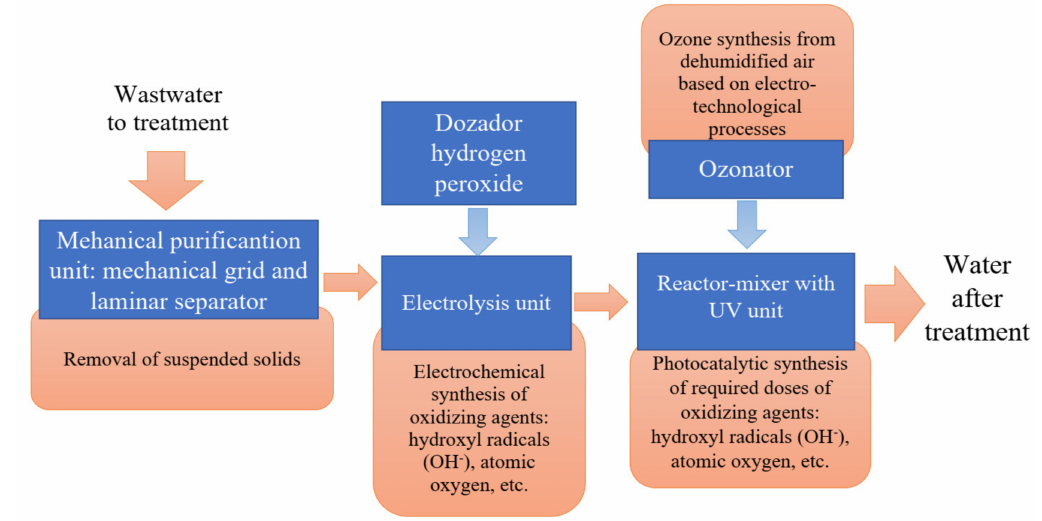
Figure 4. The structural diagram of the electrotechnological water treatment complex using AOPs (ozonation, UV irradiation, and electrolytic anodic